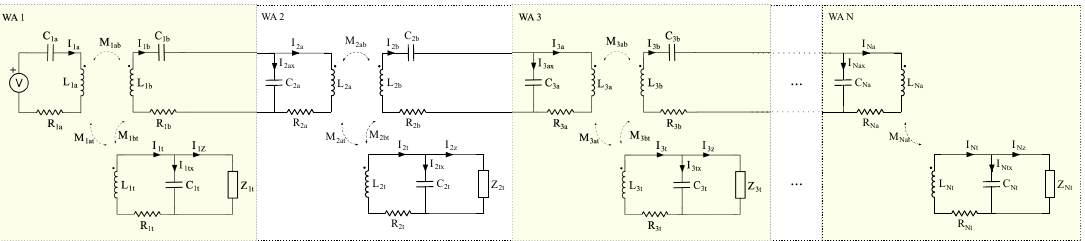
Figure 4. N wireless areas network branch circuital